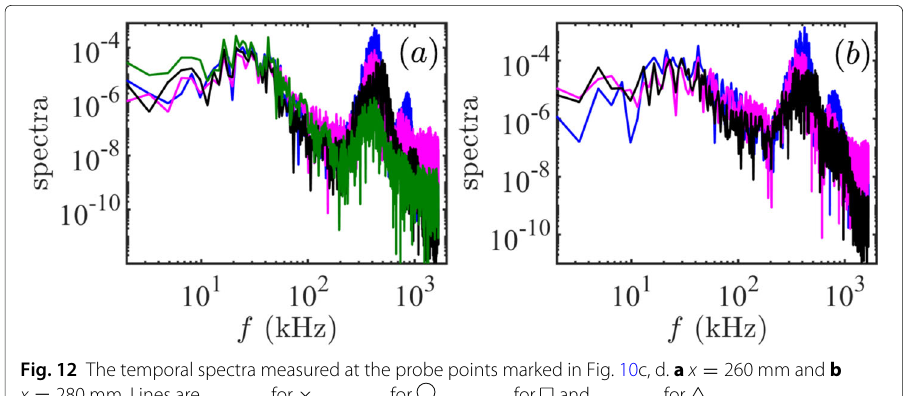
Fig. 12 The temporal spectra measured at the probe points marked in Fig. 10c, d. a x = 260 mm and b x = 280 mm. Lines are for × , for , for and